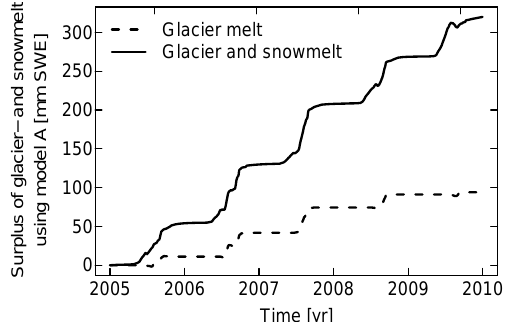
Figure 8. Accumulated differences (model A minus model B) in discharge at the Huben gauge.